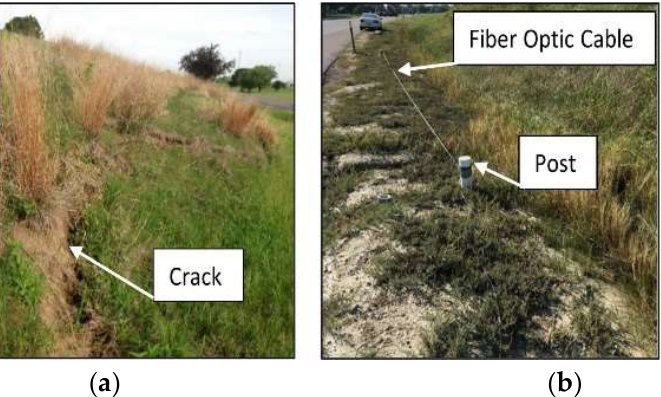
Figure 5. Scene of I-180 Slope. ( a ) Crack on I-180 Slope. ( b ) DSS System Installed on I-180 Slope.